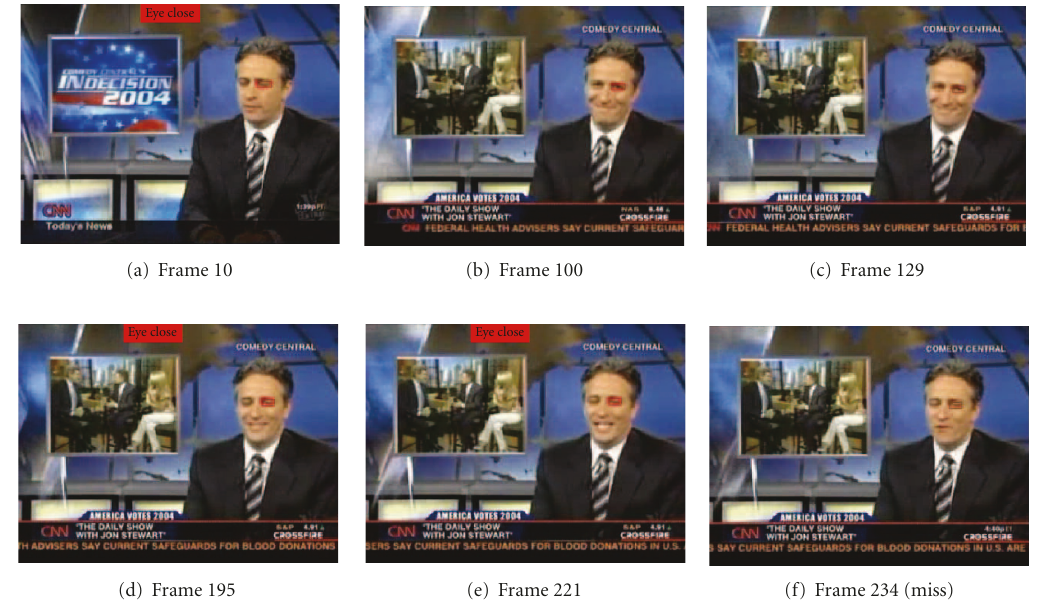
Figure 7: Examples of the blink detection results for news report videos. Red boxes are tracked eyes, and the blue dots are the center of the eye locations. The red bar on the top-left indicates the presence of closed